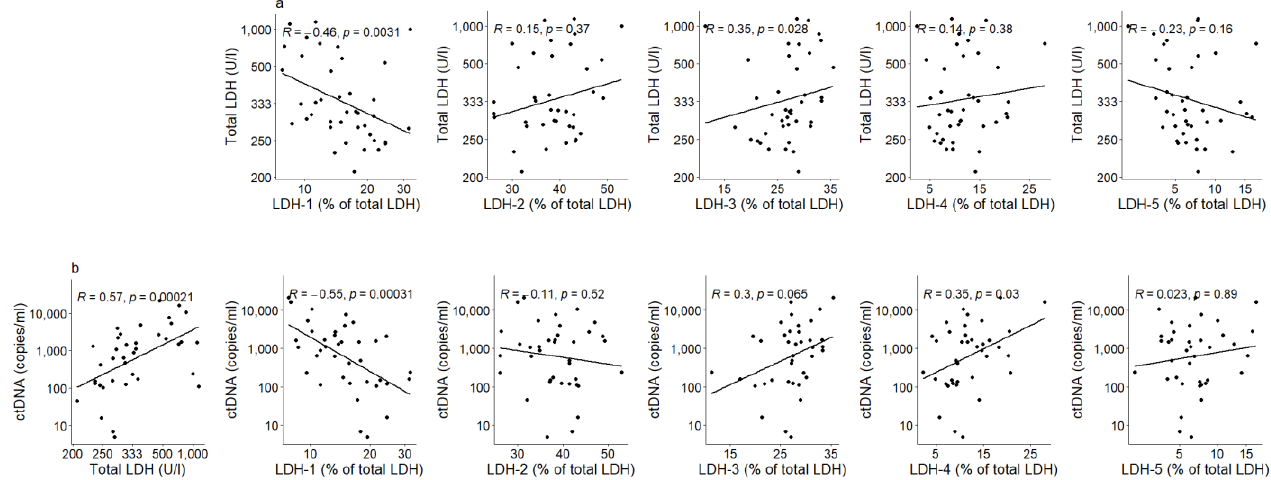
Figure 5. Correlation between LDH isotypes, total LDH levels and ctDNA levels. ( a ) Correlation between LDH isotypes and total LDH levels at baseline. ( b ) Correlation between LDH isotypes and ctDNA at baseline. ctDNA levels are shown on a log-transformed axis. One patient had undetectable ctDNA levels at baseline. For visualization purposes, the ctDNA copy number of this patients was replaced by 5 (~lowest value in this plot).